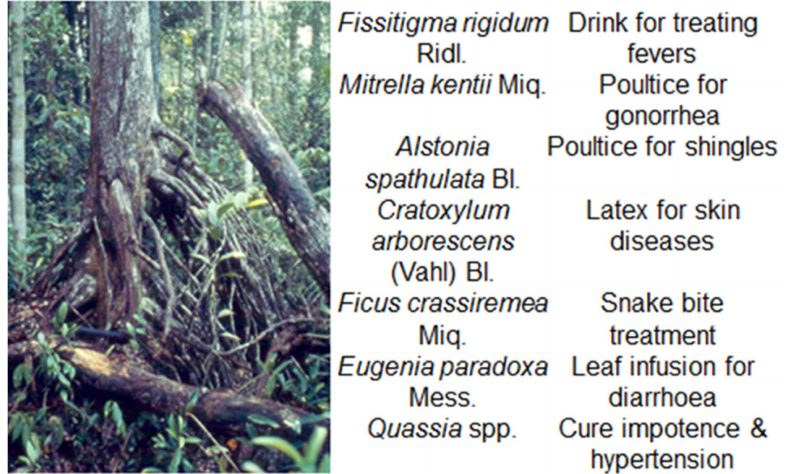
Figure 28. An illustration of the frequently ignored services provided by Peat Swamp Forests in Southeast Asia. After Chai et al. [86]. Photograph Edward Maltby.